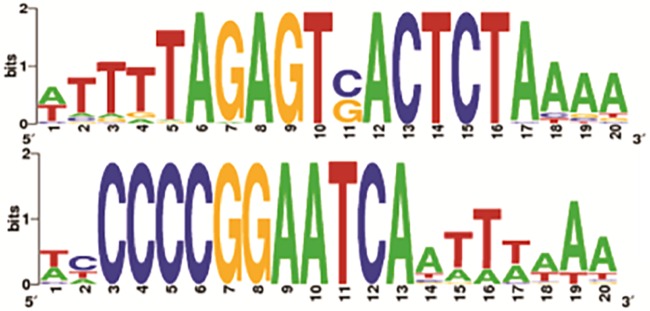
Sequence logos of the promoter motifs predicted from alignments of the 5′ upstream regions (top) and putative promoter for cyanophage A-1 showing a sequence logo created from an alignment of 43 sequences (bottom). The putative promoter for cyanophage N1 shows a sequence logo created from an alignment of 21 sequences. The heights of the letters are proportional to the levels of sequence conservation of the nucleotides at the respective positions.